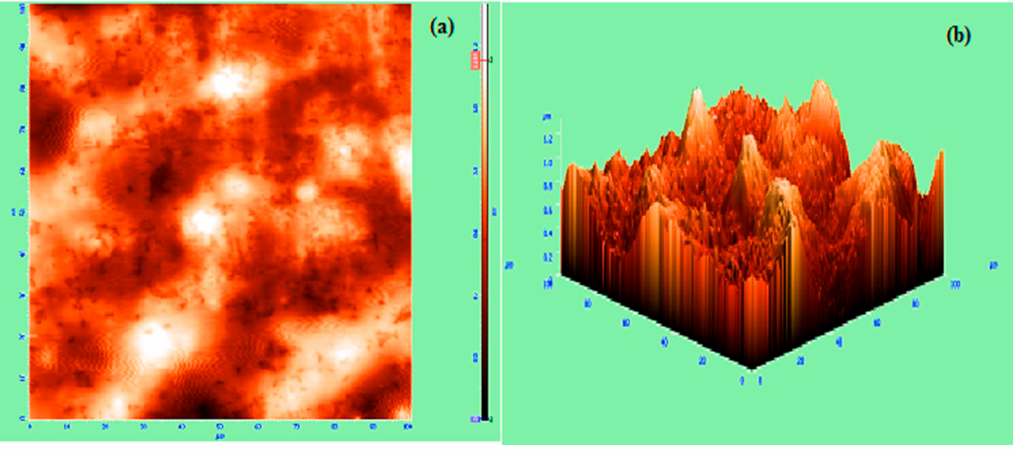
Figure 4. Atomic force microscope (AFM) surface morphologies of CrN film as deposited: ( a ) top view of surface roughness in 2D, ( b ) 3D view of CrN